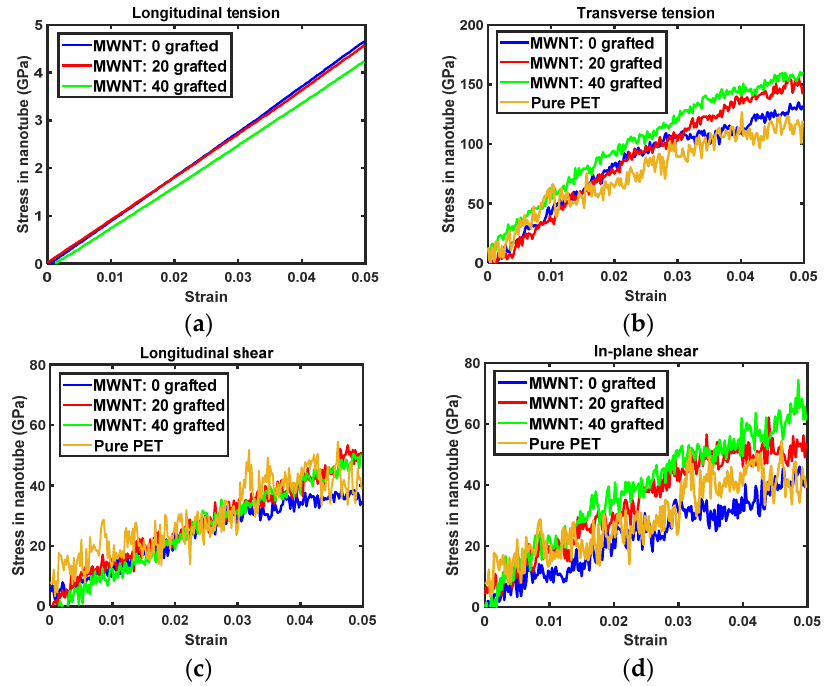
Figure 5. Transversely isotropic stress-strain relation of MWNT/PET nanocomposites: ( a ) longitu- dinal tension, ( b ) transverse tension, ( c ) longitudinal shearing, ( d ) in-plane shearing.